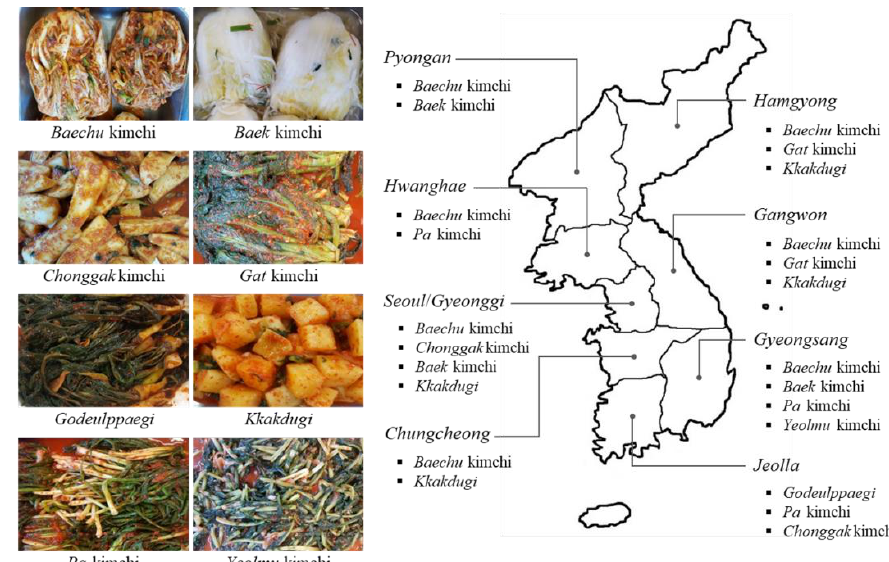
Figure 1. Kimchi varieties available across different provinces in Korea. Baechu kimchi: Napa cabbage kimchi; Baek kimchi: Napa cabbage kimchi prepared without red pepper powder; Chonggak kimchi: ponytail radish kimchi; Gat kimchi: mustard leaf kimchi; Godeulppaegi : Korean lettuce kimchi; Kkakdugi : diced radish kimchi; Pa kimchi: green onion kimchi; Yeolmu kimchi: young radish kimchi.